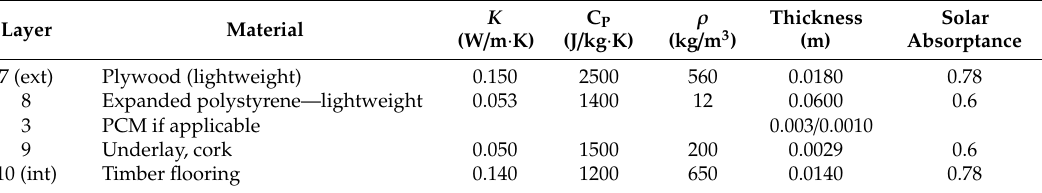
Table A2. Building materials for floor